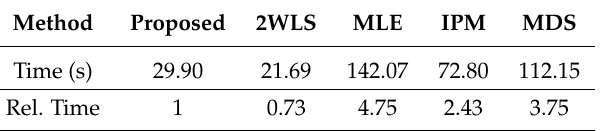
Table 4. Computation